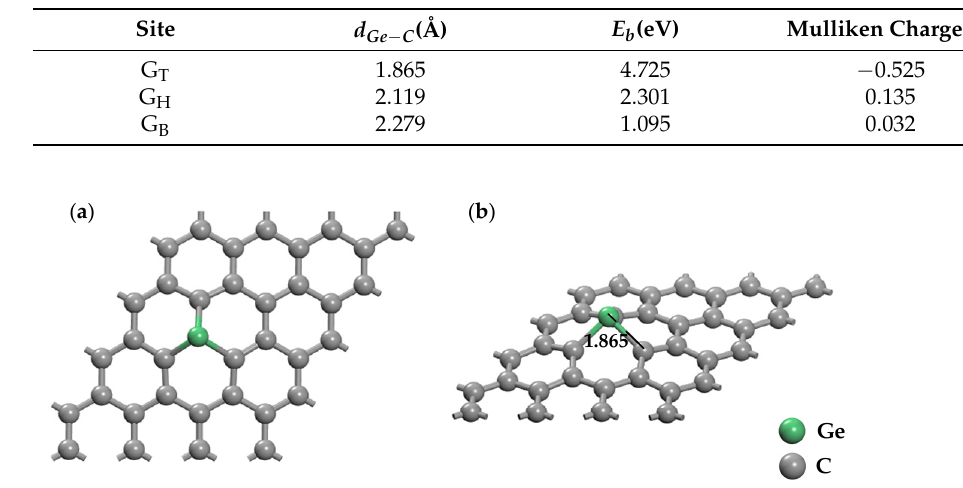
Figure 3. The optimized structure of Ge-doped graphene (GeG) at T doping site ( a ) top view ( b ) side view. Table 1. The structural parameters of Ge-doped graphene.